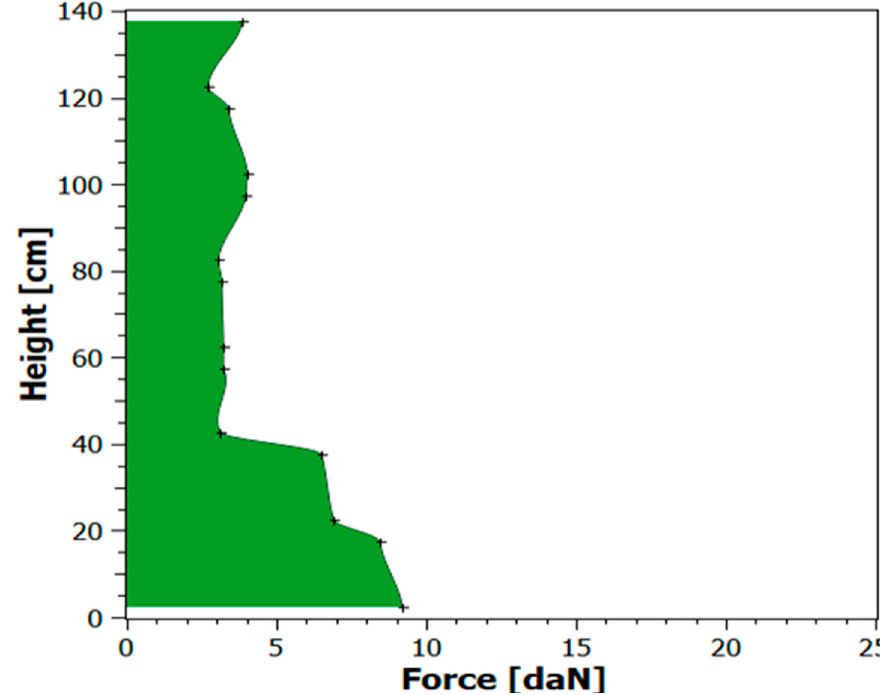
Figure 6. Sensor arrangement FEF-200 on the cargo prepared for testing.